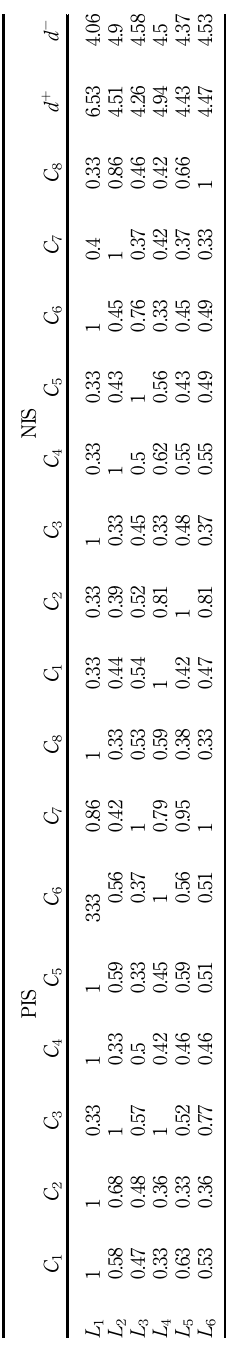
Table 5. Grey relational grade for